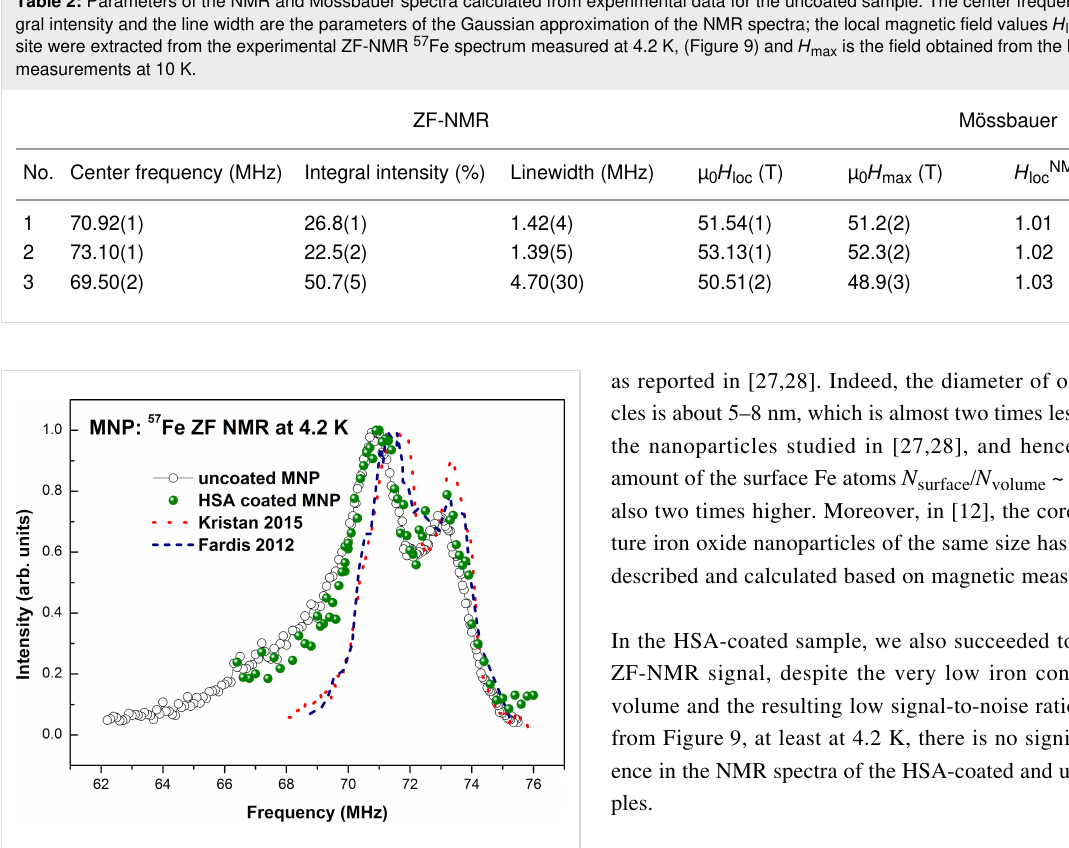
tra is obvious, especially with regard to the position and width of the main narrow